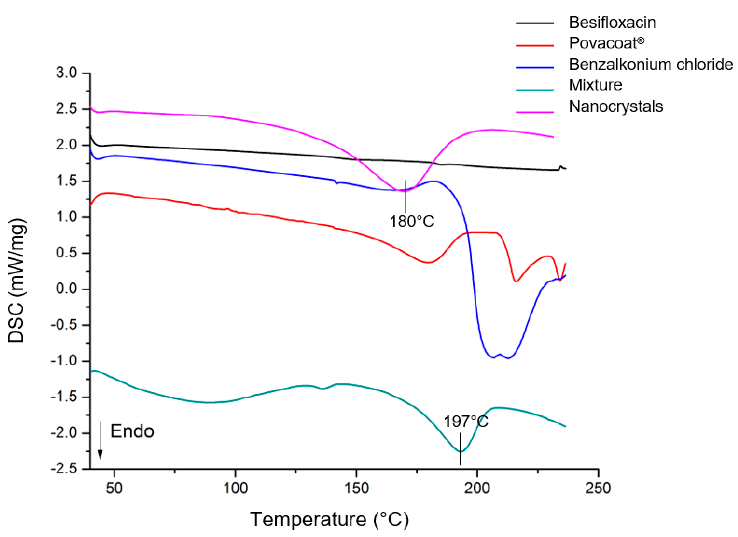
Figure 6. DSC curves of formulation components, mixture (same proportion as formulation), and besifloxacin nanocrystals. besifloxacin